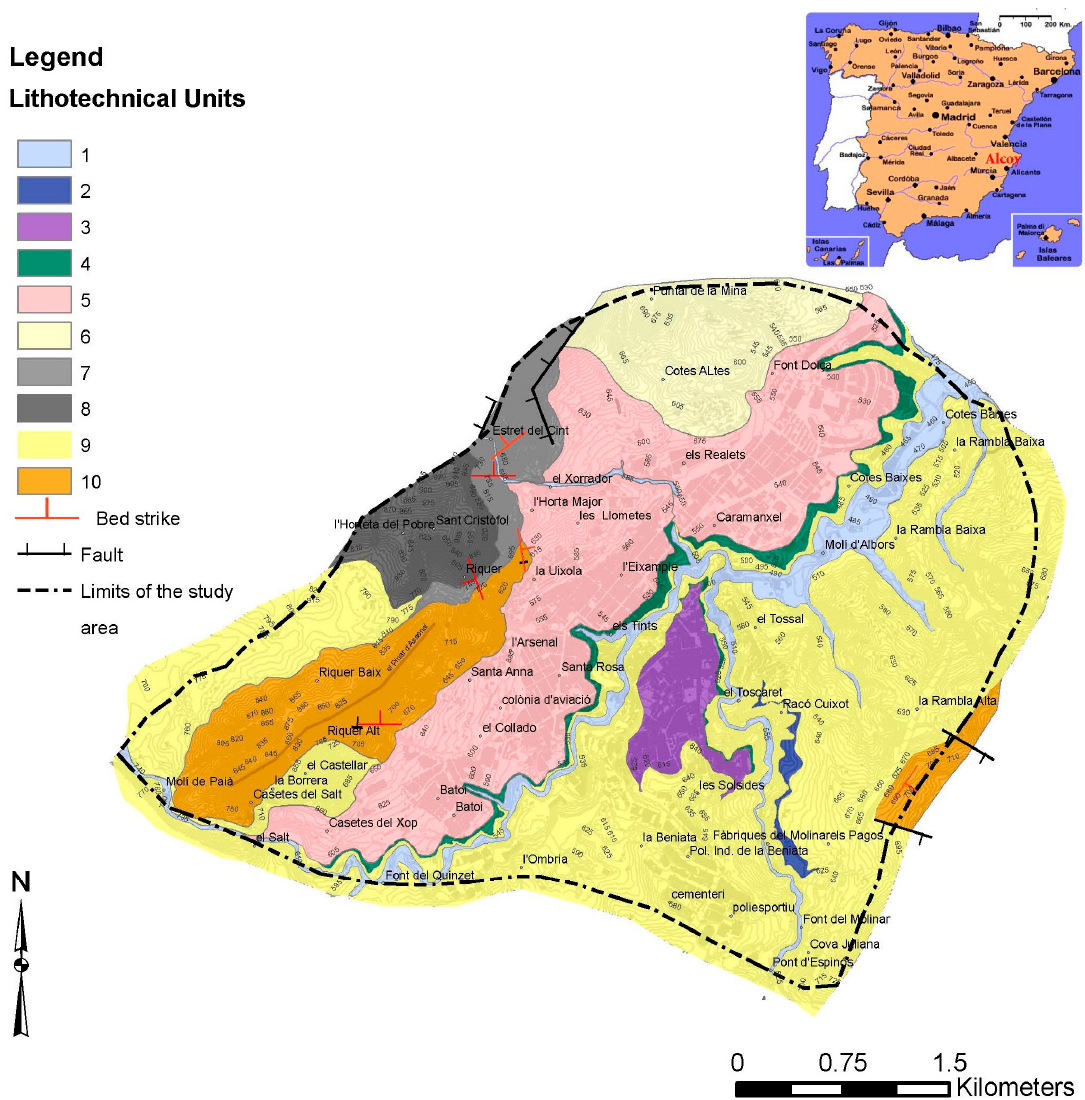
Figure 3. Lithotechnical map of the study area. (1) gravels and sands with variable amounts of silts and clays (Alluvial deposits, Holocene). (2) Travertines (Quaternary). (3) Silts and sands with gravels (alluvial terraces, Quaternary). (4) gravels and sands with variable amounts of silts and clays (Alluvial deposits, Pleistocene). (5) Reddish gravel and sands with silts and clays (alluvial fan deposits, Quaternary). (6) Marls (Miocene). (7) Bioclastic limestone (Miocene). (8) Biodetritic limestone (Miocene). (9) Marls (Marls in tap facies, Miocene). (10) Bioclastic limestone (Oligocene).